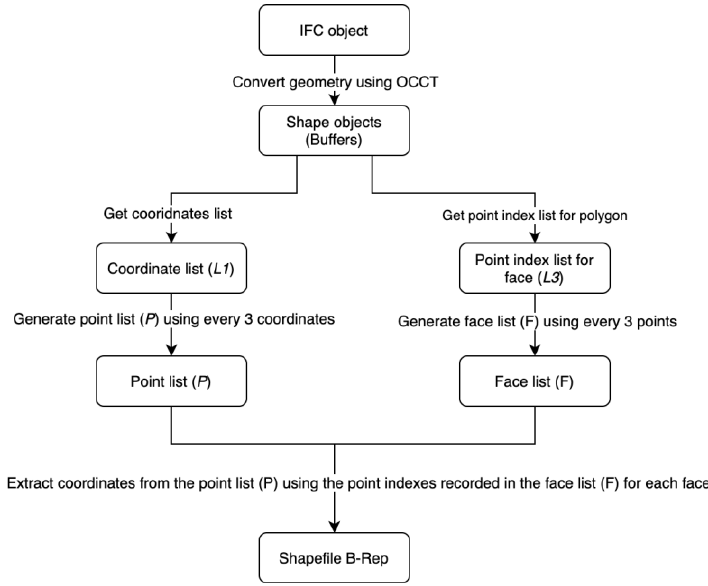
Figure 8. Converting OCCT B-Rep to shapefile B-Rep.